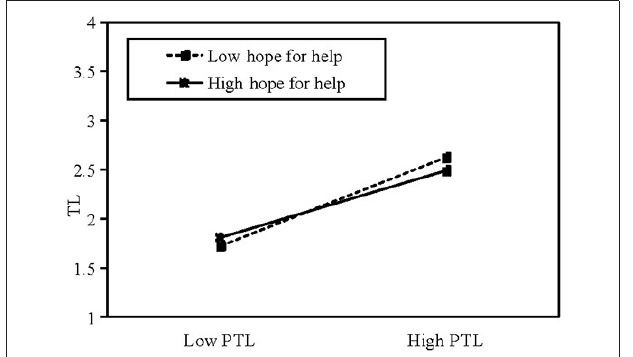
FIGURE 4 | The mediating effect of hope-for-help motivation on VL. PTL: length of patient’s textual messages.